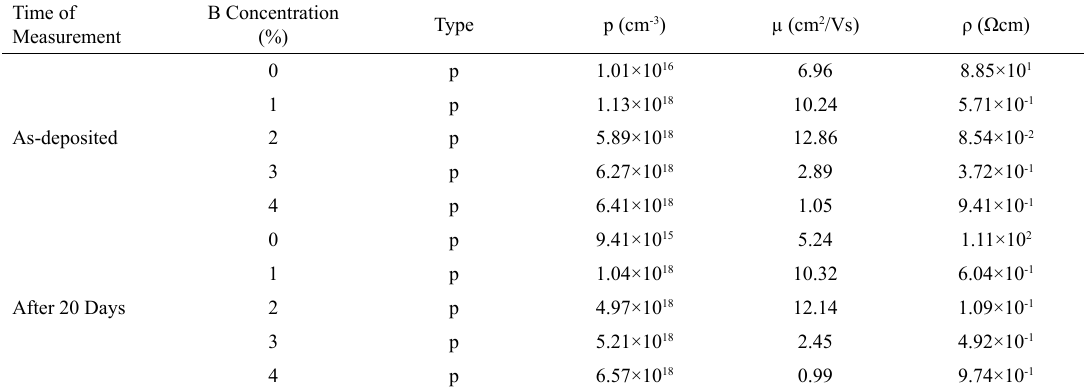
Table 4. Carrier type, concentration (p), mobility (µ) and resistivity (ρ) obtained from Hall effect measurement for the thin films of B-N codoped ZnO with various B concentrations along with measurements after 20 days. Time of B Concentration Measurement